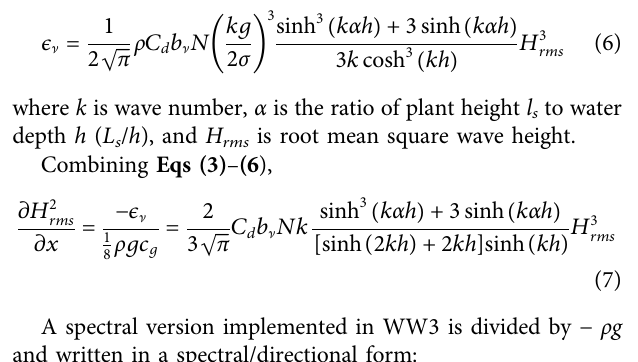
Frontiers in Built Environment |